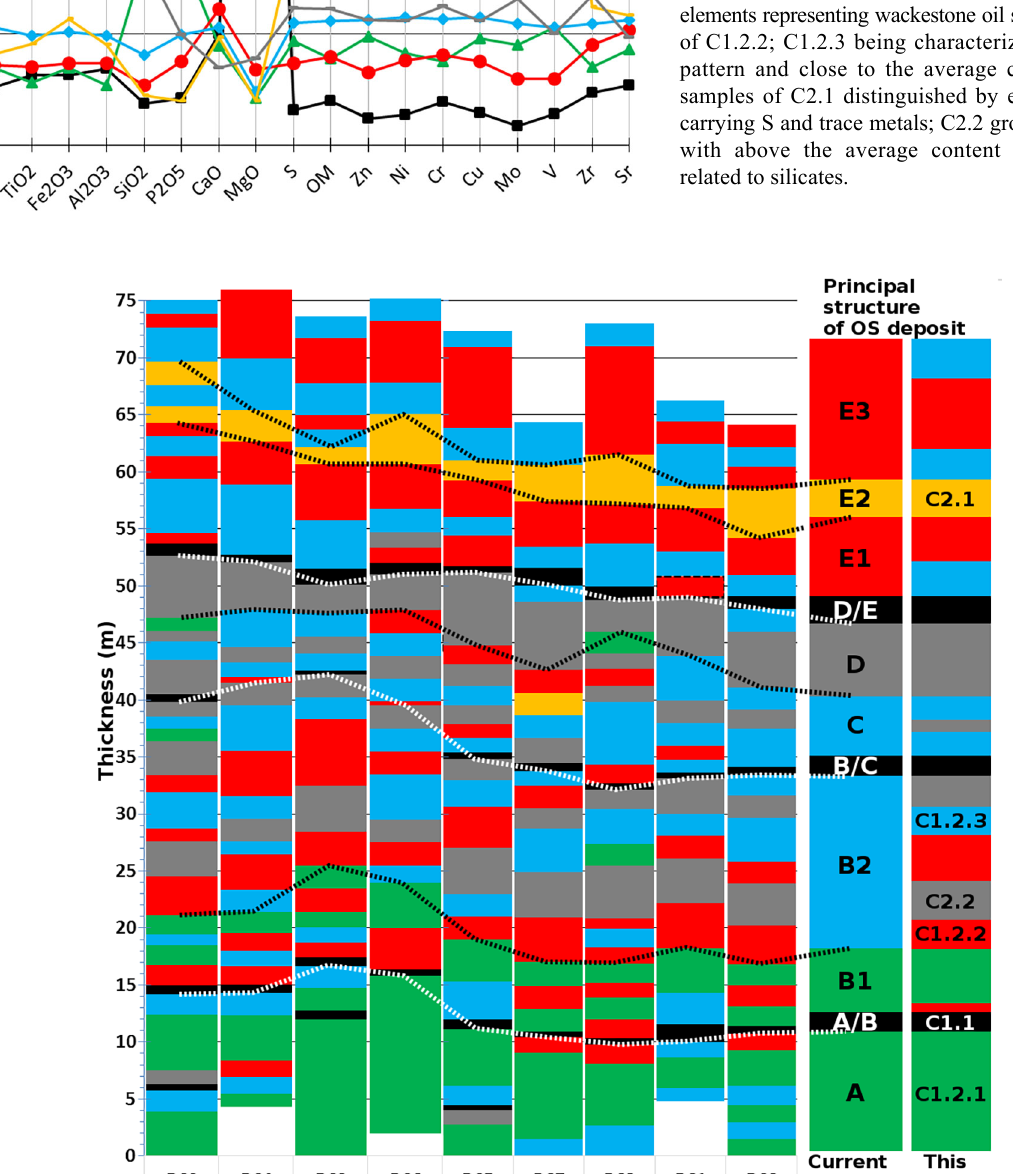
Fig. 8. The position of samples belonging to different clusters in nine oil shale sequences (wells DC1–DC9) revealing the complex structure of the deposit. For better reading three cross sections are uplifted and dashed lines are indicating the base of currently separated oil shale and barren dolomitic limestone layers. For comparison a simplified column of the current structure (NB! layer thicknesses are approximate) with corresponding chemical properties indicated by colours is plotted aside the summarized column of nine cross sections, illustrating the alternation of chemically different types of oil shale/dolomite samples in the sequence.